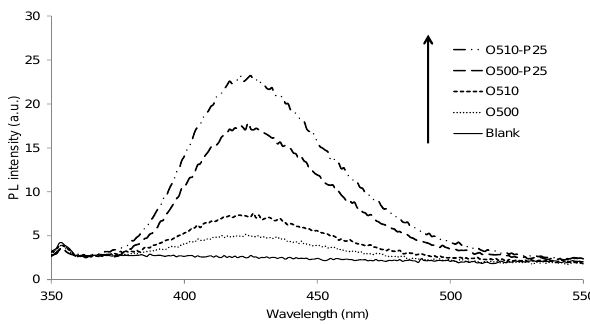
Figure 4. PL spectra of 2-OHTA formed by 45min irradiation of different coated meshes. Initial TA concentration is 5 × 10 − 4 M; ex- citation is at 315nm; final drying temperature is 300 ◦